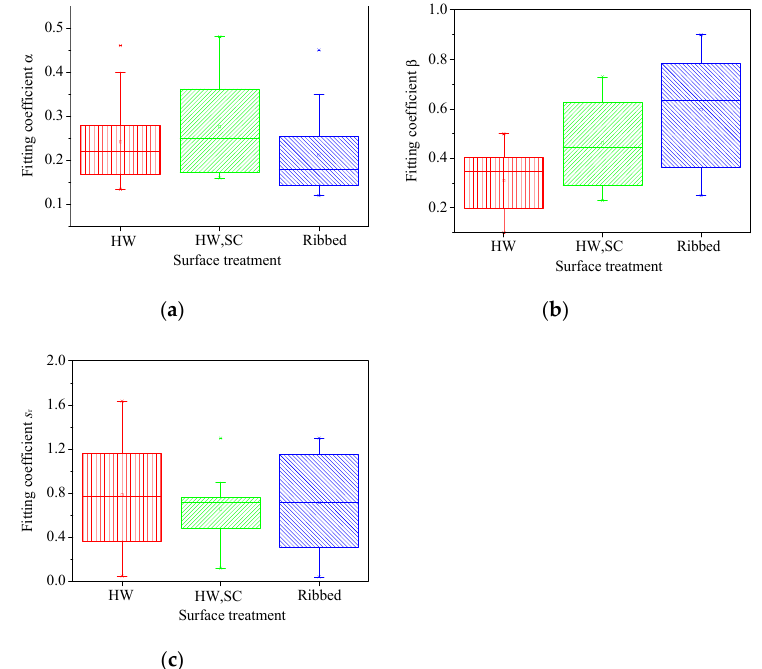
Figure 15. The box plots for parameters fitted by stirrup-containing specimens test results with regard to specific surface characteristics ( a ) α ; ( b ) β ; and, ( c ) s r .